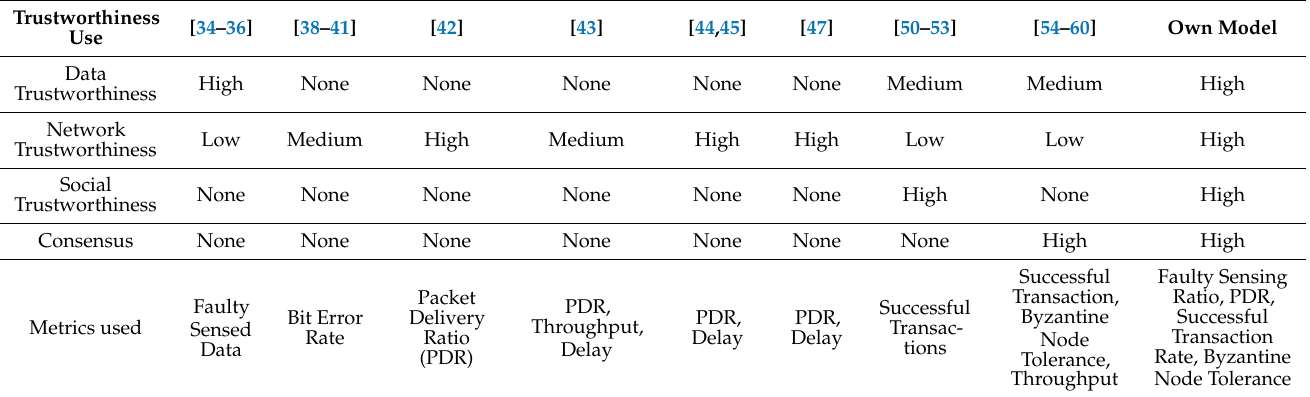
Table 1. Qualitative benchmark of the studied trustworthiness